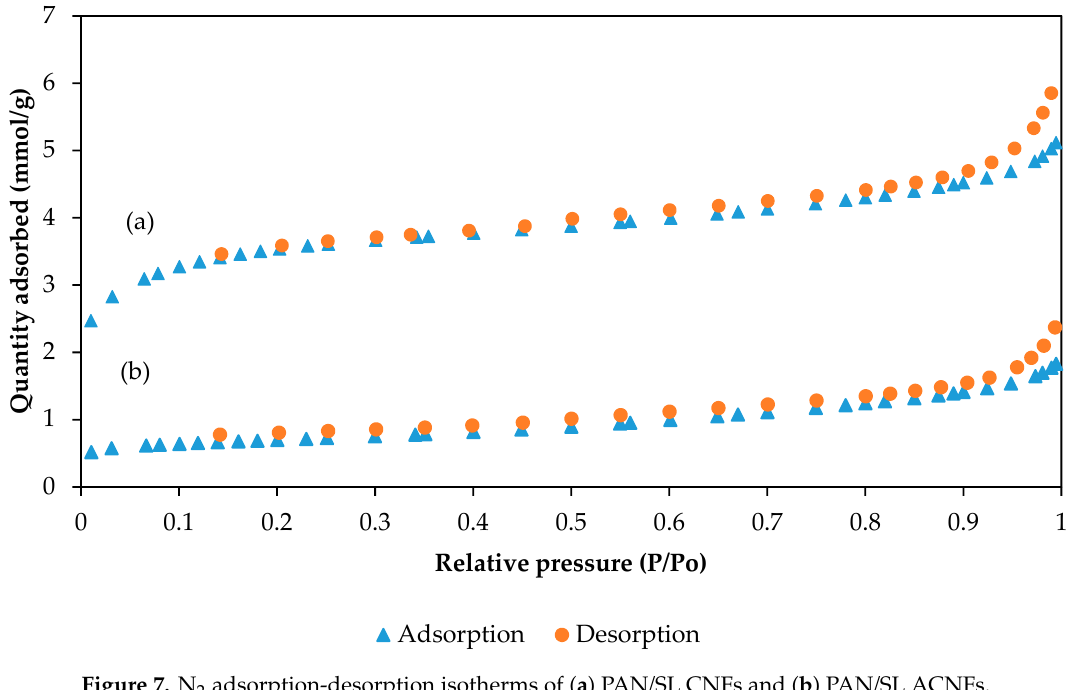
Figure 7. N 2 adsorption-desorption isotherms of ( a ) PAN / SL CNFs and ( b ) PAN / SL ACNFs. Table 1. Textural characterization of PAN / SL CNFs and PAN / SL ACNFs.